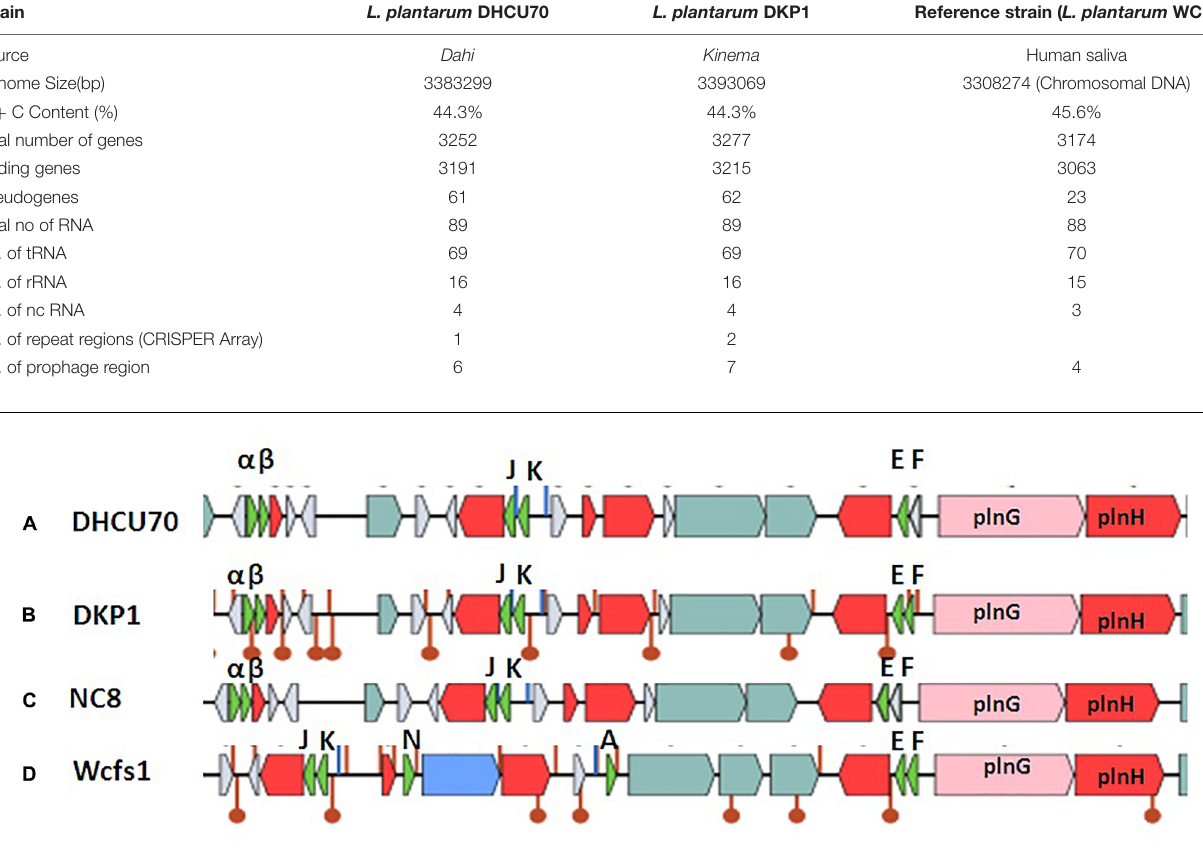
FIGURE 4 | Genetic organization of pln locus of (A) : Lactobacillus plantarum DHCU70; (B) L. plantarum DKP1; (C) : Lactobacillus plantarum NC8; (D) : Lactobacillus plantarum WCFS1; Indicators: α – NC8 α , β – NC8 β , J – pln J, K- pln K, E- pln E, F- pln F, Red color indicated immunity protein.